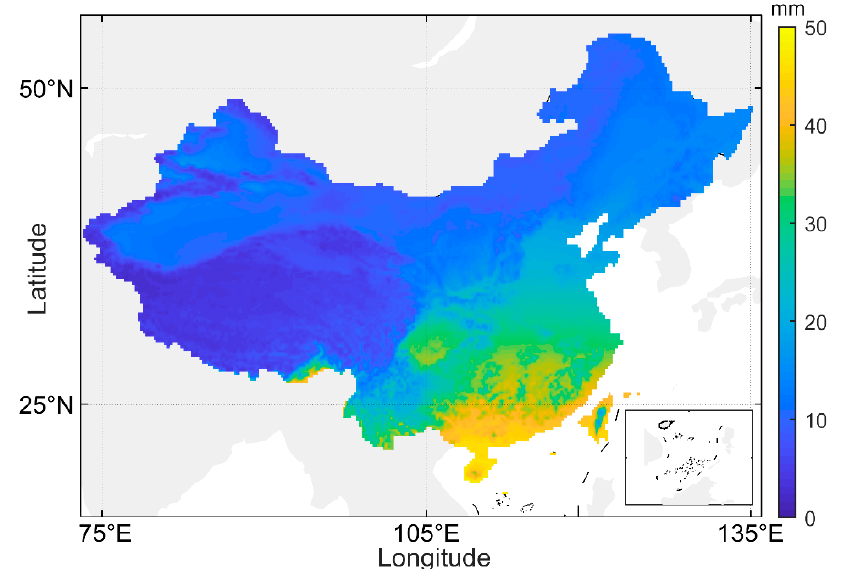
Figure 2. Mean PWV (millimeters) calculated from the ERA-PWV in the six-year period from 2013 to 2018 over China.